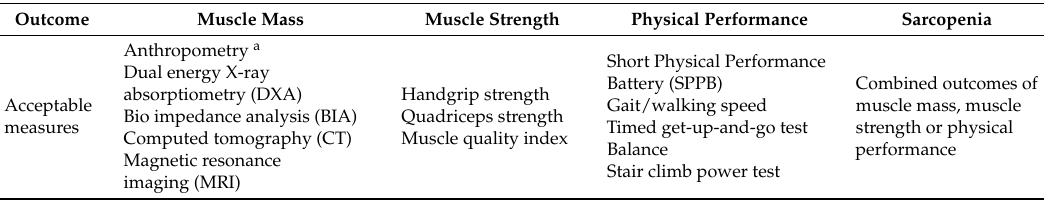
Table 1. Types of measures considered for relevant outcomes, namely muscle mass, strength, physical performance, and